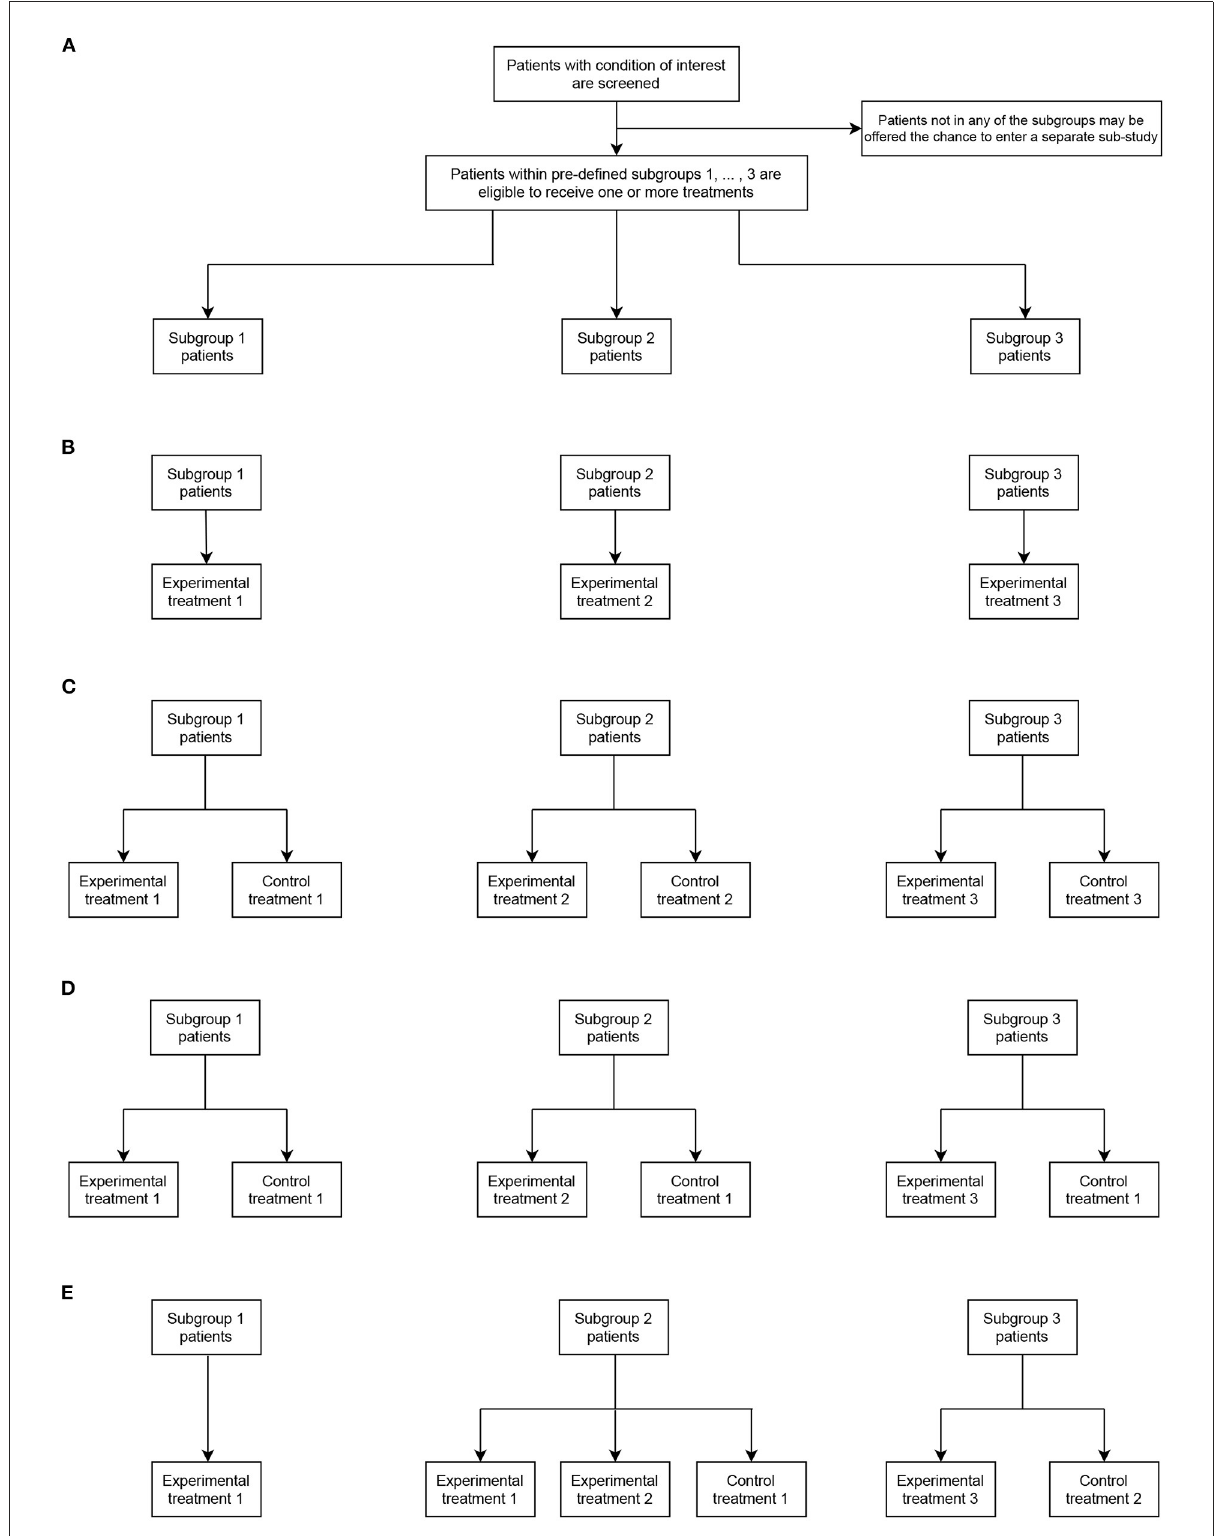
FIGURE1 Representative umbrella trial designs in the case of three subgroups ( S = 3) and three experimental treatment arms ( T E = 3). (A) indicates the fundamental structure of a trial of this type. (B–E) give different design options allowing assignment to the experimental and possibly control treatments in each subgroup (as defined by the values of T C , C s , and E s